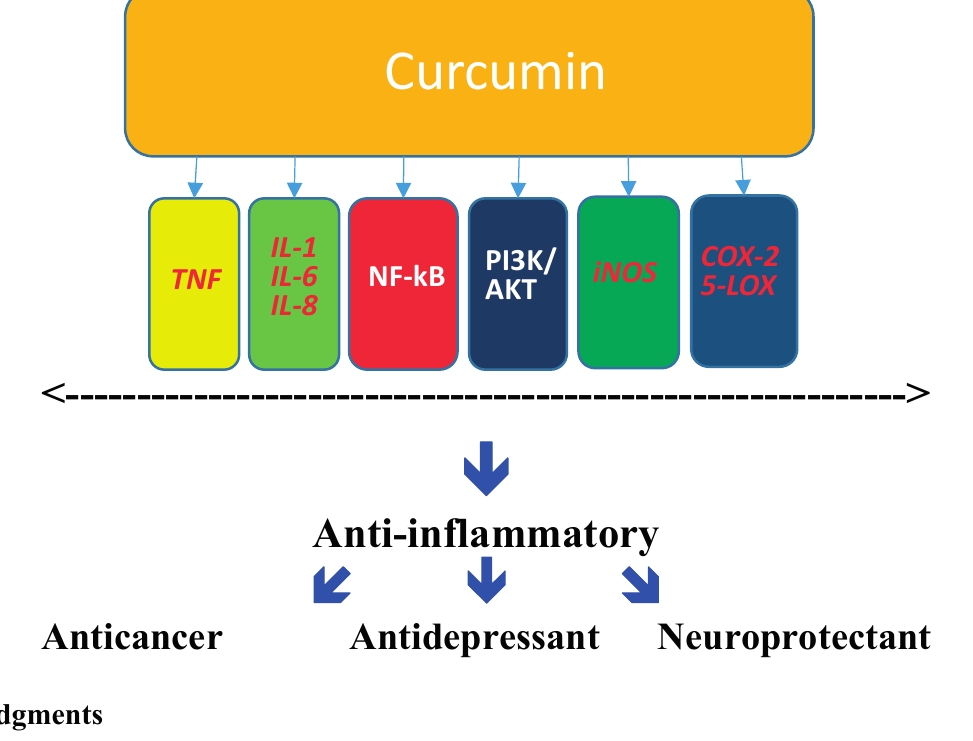
Figure 1. Potential Molecular Mechanisms Affected by Curcumin. The inhibition of cell signaling pathways such as Akt, NF- κ B, or PI3K [139], has been suggested as the mechanism responsible for anticancer effects of curcumin. Curcumin may also inhibit the activity and synthesis of the enzymes implicated in inflammation such as cyclooxygenase-2 and 5-lipooxygenase. Moreover, its anti-inflammatory effect may be linked to inhibition of pro-inflammatory leukotrienes as well as to its neutrophil function [63,64]. Inhibition of TNF [59] may contribute to a physical interaction with other key signaling protein like BDNF that might enhance its antidepressant